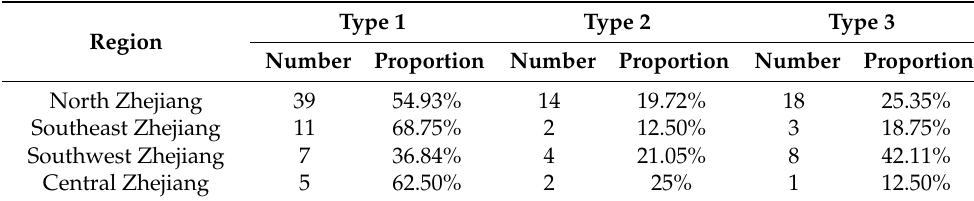
Table 2. Regional differences of spatial spillover types. Type 1 Type 2 Type 3 Region Number Proportion Number Proportion Number